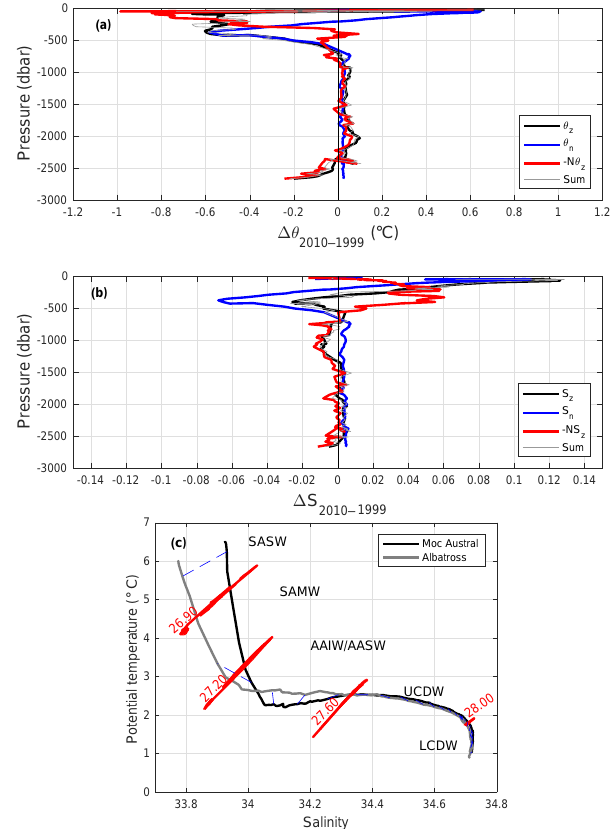
Figure 5. Isobaric changes from 1999 to 2010 ( θ z , black line) de- composed into changes along neutral surfaces ( θ n , S n , blue line) and changes due to the vertical displacement of isoneutrals ( − N θ z , − NS z , red line) for (a) potential temperature and (b) salinity. The grey line shows the sum of both components. The lower panel (c) shows the average profile of θ/S for each cruise together with the densities that divide the water column into the different water masses (26.90, 27.20, 27.60 and 28.00kgm − 3 , red lines) and the link in between points of equal pressure (dashed blue